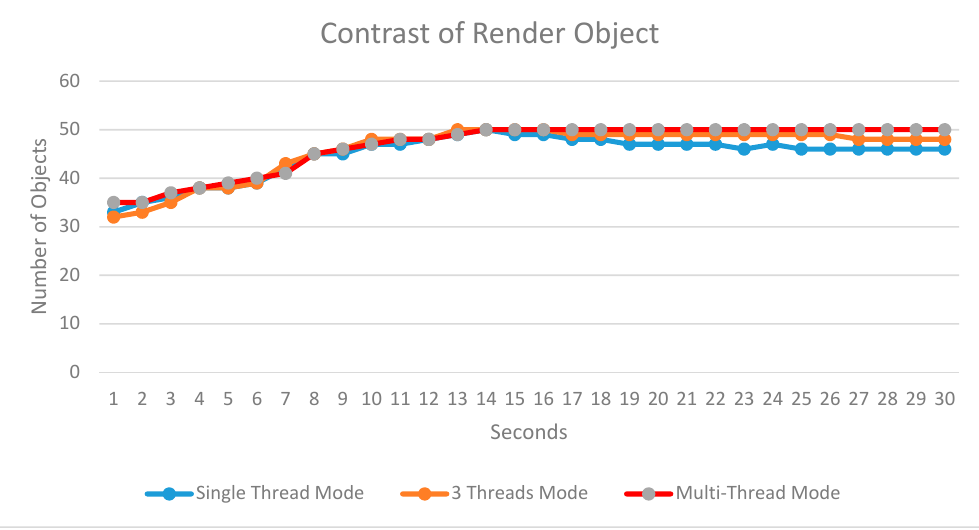
Figure 7. Comparison of the render object of the three different modes.